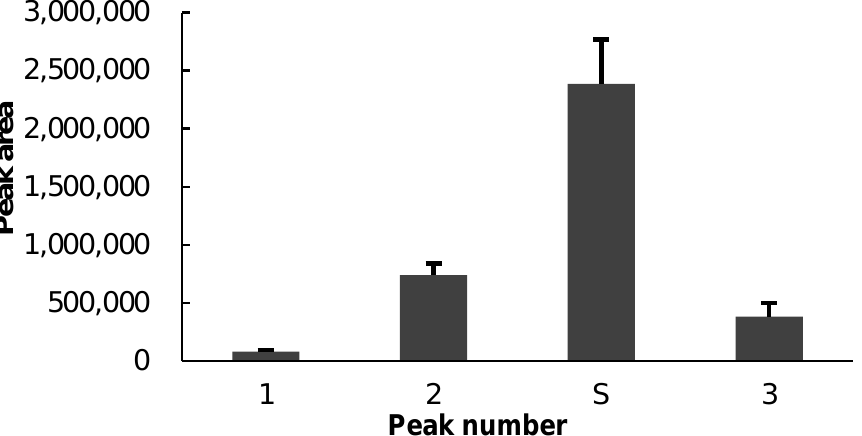
Figure 2. The GC peak areas of main peaks from S. granarius collected at 46–48 h after being sealed in